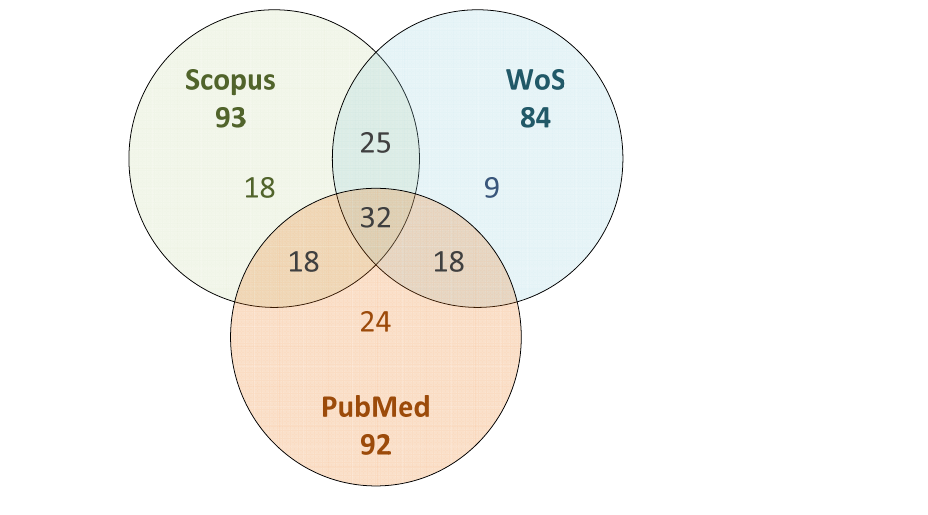
Figure 4. The distribution of included papers among the search databases. The values in bold show the number of included papers found in each database. The values in the cross sections show the number of included papers two or all three databases.